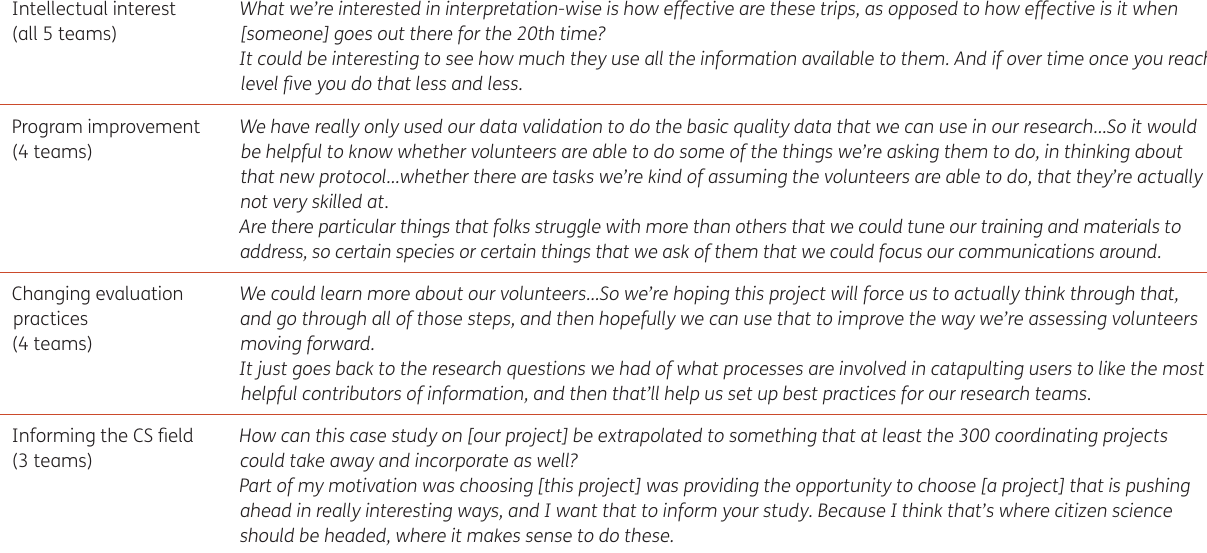
Table 3 Intentions for using the results of the secondary analysis, as described by CS